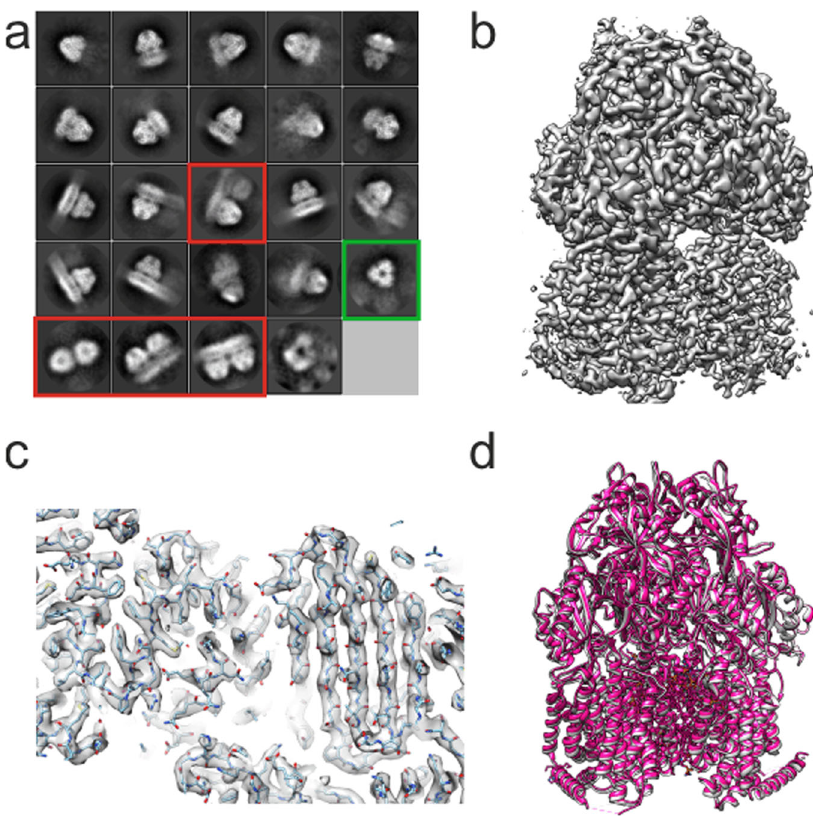
Fig. 3 CryoEM of AcrB extracted and puri fi ed in CyclAPol C 8 -C 0 -50. a Classes of AcrB in C 8 -C 0 -50 following one round of 2D classi fi cation. The classes demonstrate a range of views such as a high angle view showing putative threefold symmetry (highlighted in green) with classes showing clear doublets highlighted in red. b Side view of the AcrB cryoEM map at 3.2 Å fi nal resolution. c Representative map density of AcrB in C 8 -C 0 -50 around the top of the vestibule region. d Overlay of the cryoEM structure of AcrB in SMA 40 (PDB accession code: 6baj; pink) with the AcrB in C 8 -C 0 -50 structure (PDB accession code 7B5P; grey) demonstrating the close similarity of